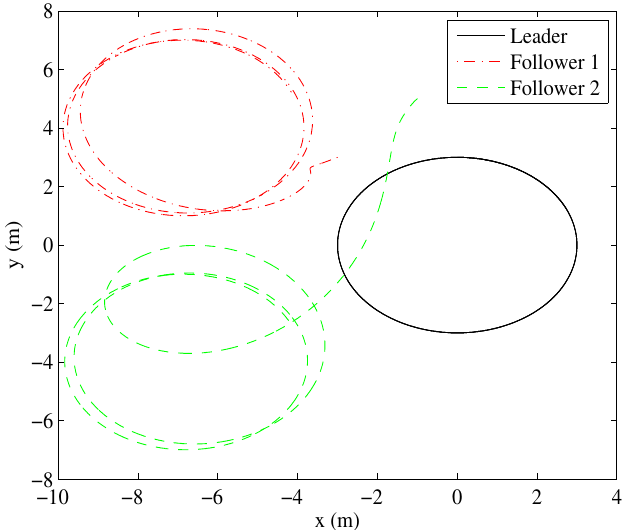
Figure 14. Positions of the leader and followers with the method from